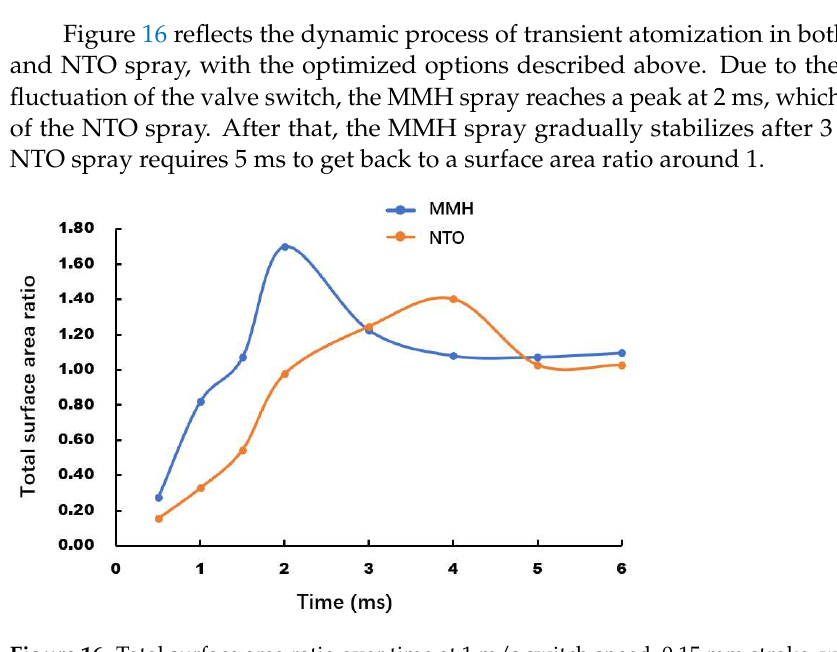
Figure 16. Total surface area ratio over time at 1 m/s switch speed, 0.15 mm stroke, with downstream throttle layout.